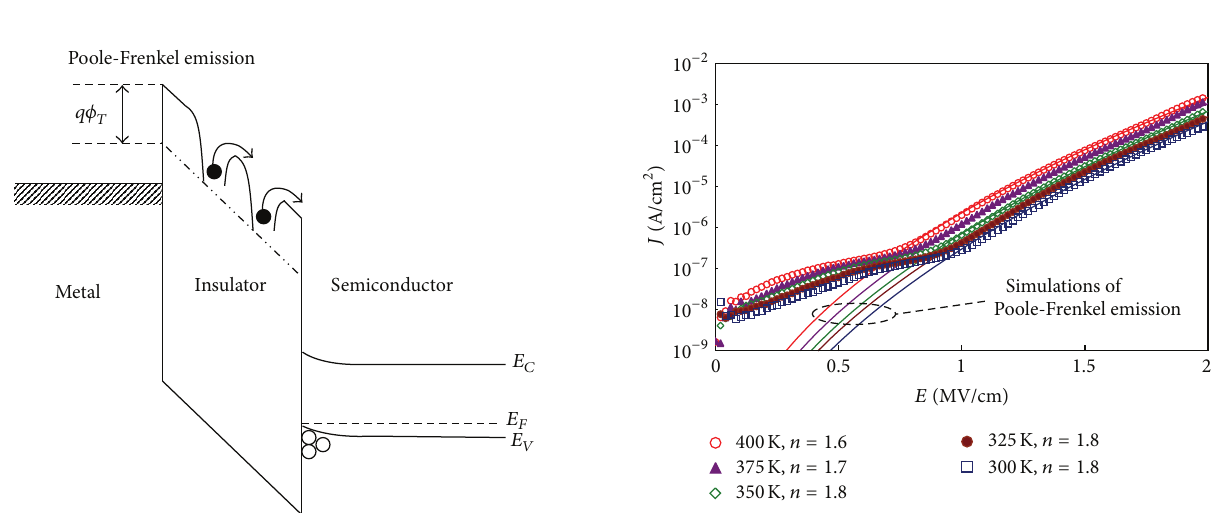
Figure 11: Schematic energy band diagram of Poole-Frenkel emis- sion in metal-insulator-semiconductor structure.